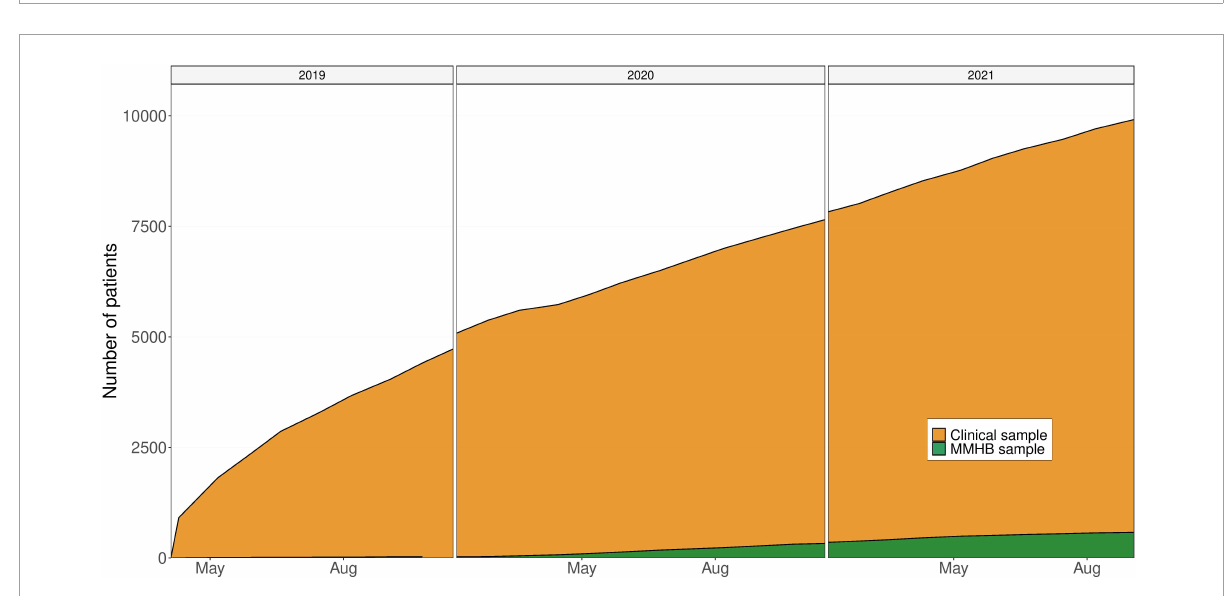
FIGURE3 Growth of the Munich Mental Health Biobank (MMHB) and Clinical samples over time. MMHB, Munich Mental Health